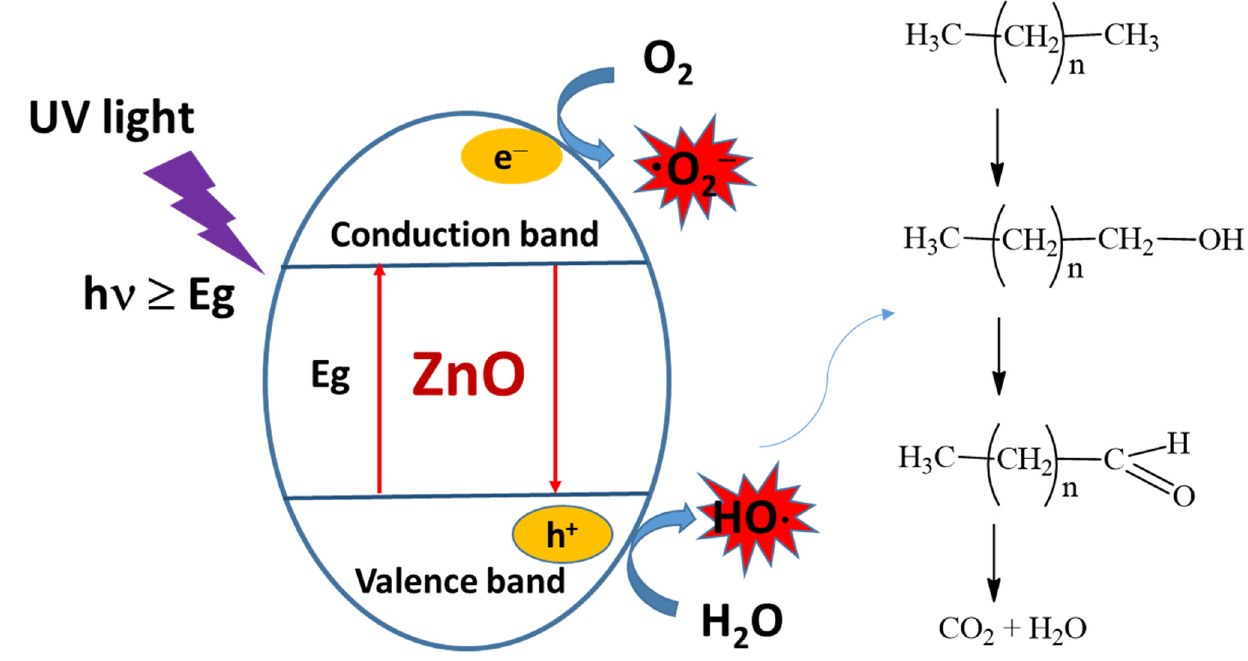
Figure 6. Mechanism of the photocatalytic degradation of organic molecules.